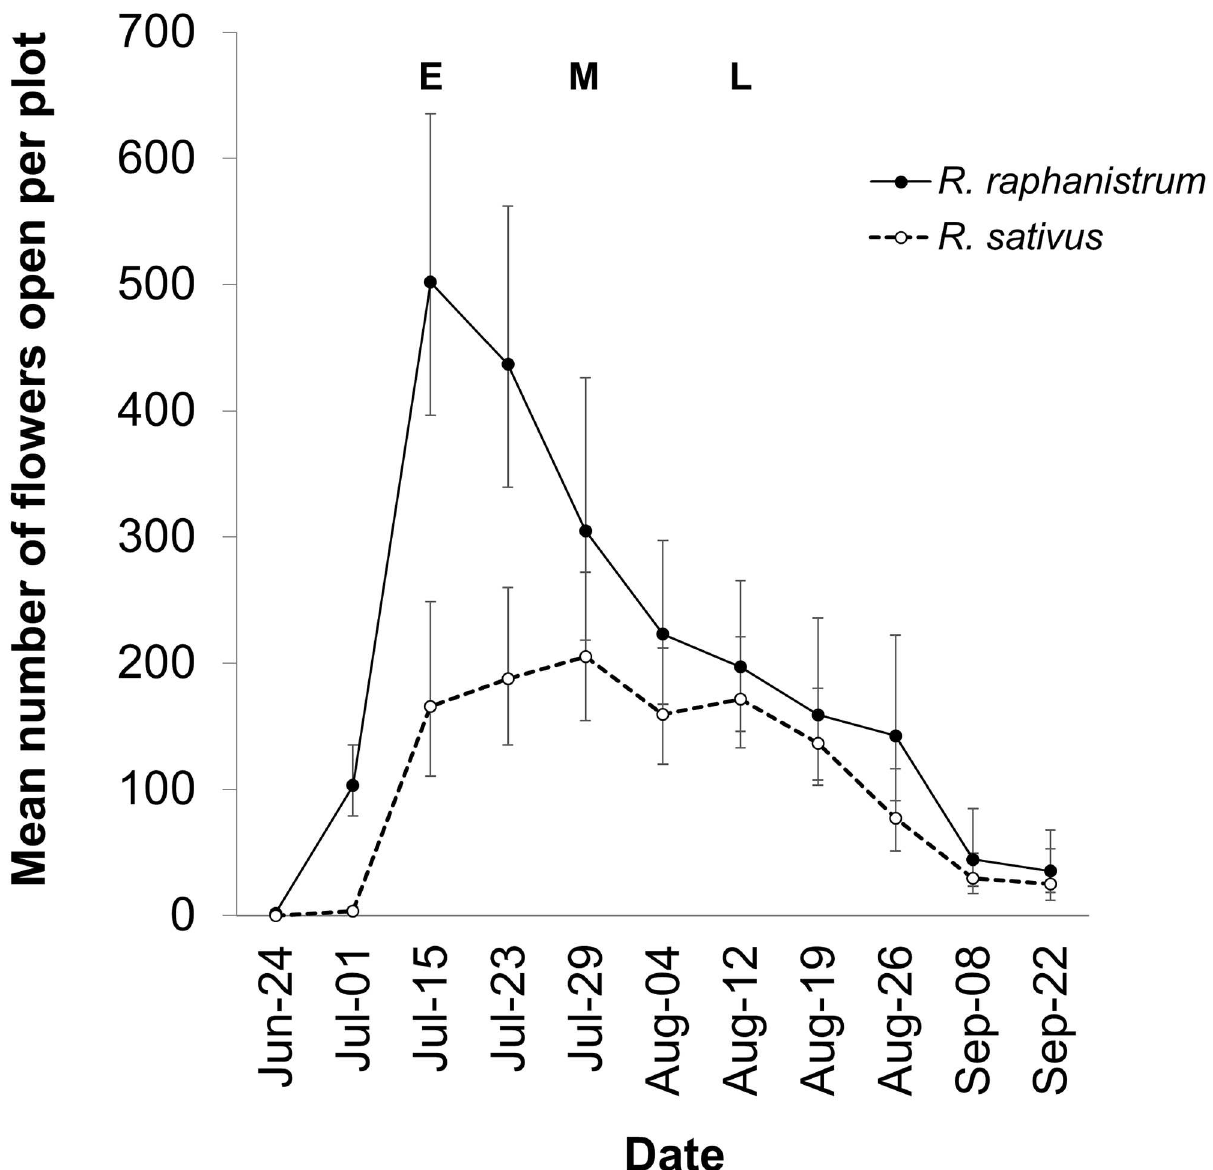
Fig 2. Least squares mean number of open flowers per harvestdate ( ± 95% CI) across the flowering season of wild and crop radish, Raphanus raphanistrum and R . sativus , respectively. Early (E), Middle (M), and Late (L) samplingevents are noted with arrows on the graph where developing fruits were